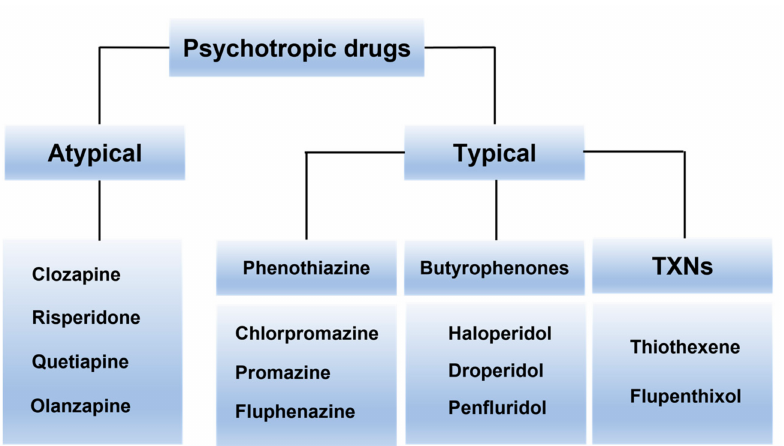
Figure 3. Classification of antipsychotic medicines and their corresponding examples. TXNs are thioxanthenes. There is also another category known as other heterocyclic psychotropic